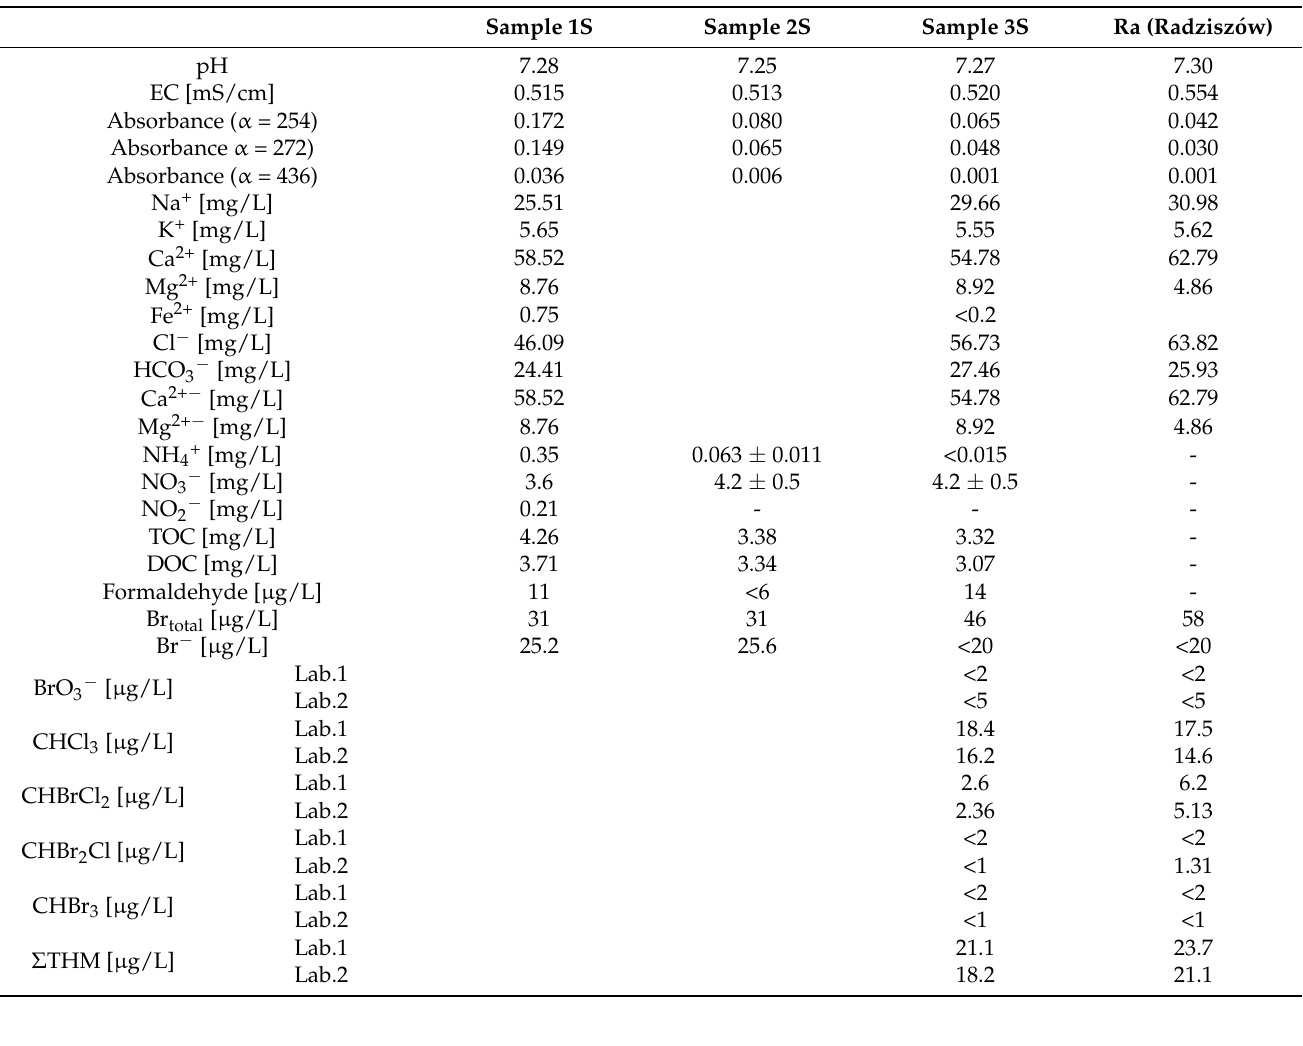
Table 3. Selected physico-chemical parameters of water from the WTP Skawina treated with ozone (sample collected on 5 June 2018).